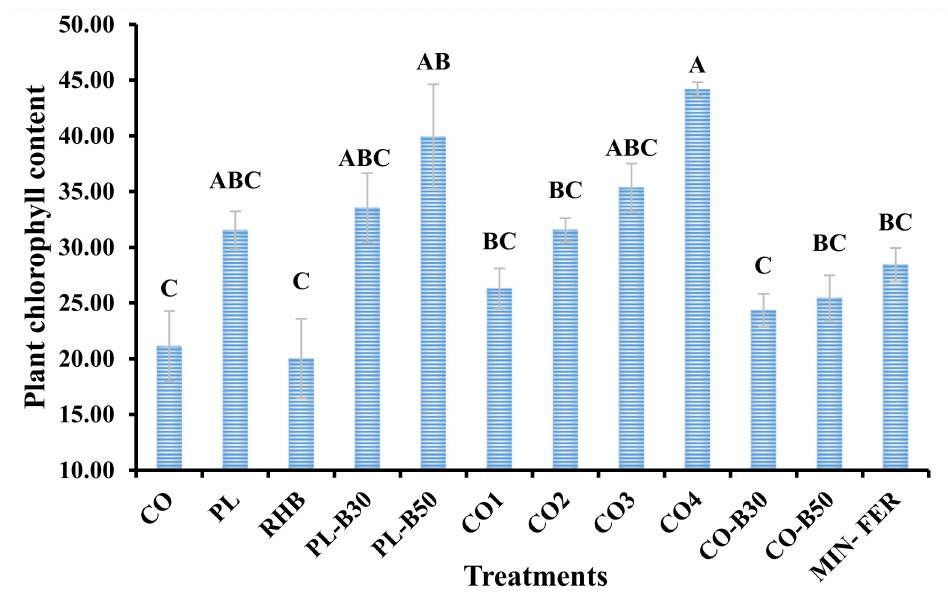
Figure 1. Chlorophyll measurement of plants according to treatment effects. Key: CO, control; PL, poultry litter; RHB, rice husk biochar; PL-B30, poultry litter blended with 30% biochar; PL-B50, poultry litter blended with 50% biochar; CO1, PL compost, CO2, CO3, CO4; CO-B30, PL compost blended with 30% biochar; CO1-B50, PL compost blended with 50% biochar; MIN-FER, mineral fertilizer at recommended rate. Different capital letters indicate significant difference between plant chlorophyll content between each treatment according to Tukey test set at 95% confidence level ( α =